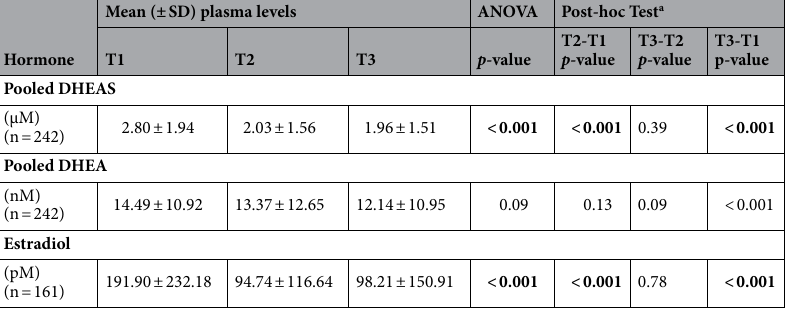
Table 3. Mean plasma levels of biomarkers along hormonal pathway across the study time points. a Bolded values indicate statistical significance with cut-off for Bonferroni-post hoc set at 0.0167.